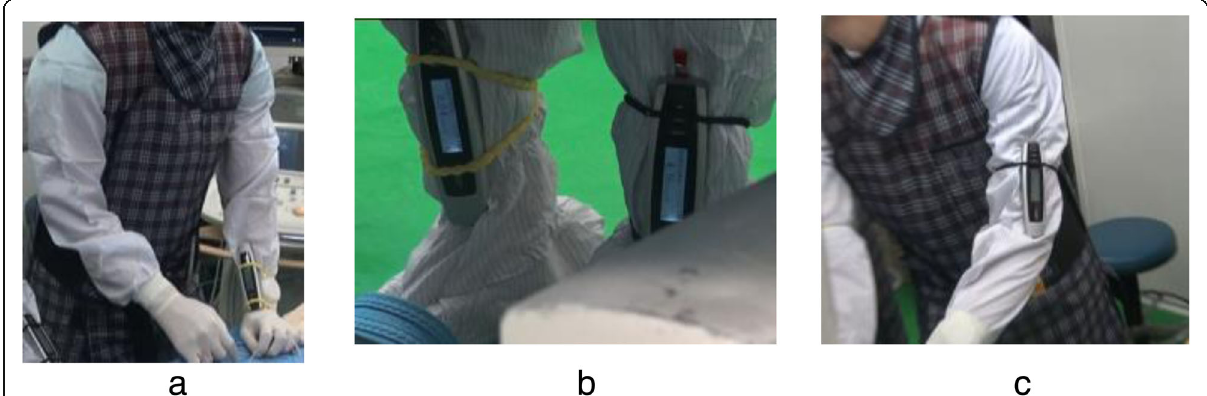
Fig. 2 Location of dosimeter for the operating physician. The dosimeter is attached to various unprotected body parts of the operating physician to measure radiation dose rates: a hands, b legs, c